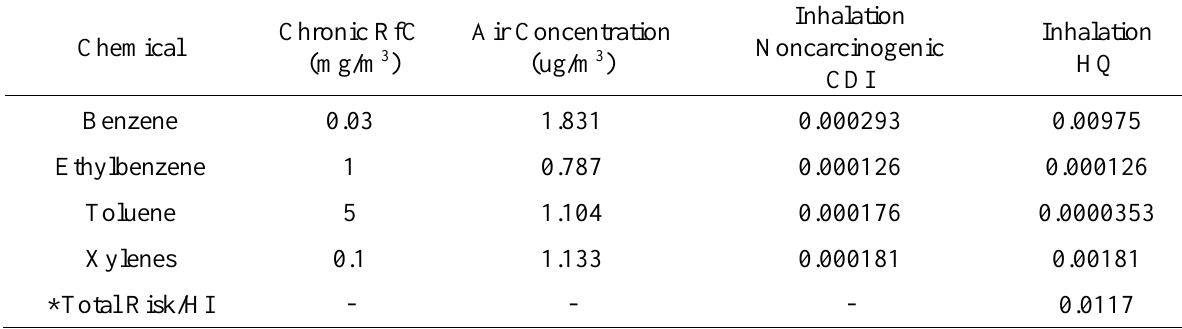
Table 5. Inhalation Noncarcinogenic (HQ)